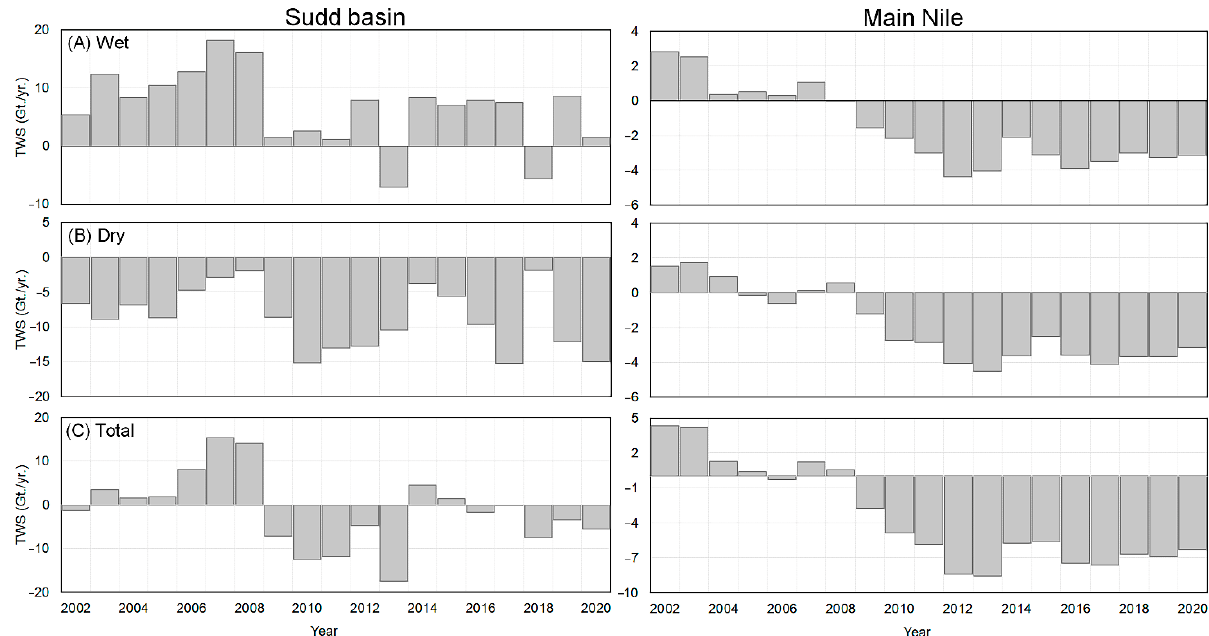
Figure 6. TWSA dynamics during the wet and dry seasons between 2002 to 2020 across the two main water sinks in the NRB, Sudd Basin, and Main Nile.